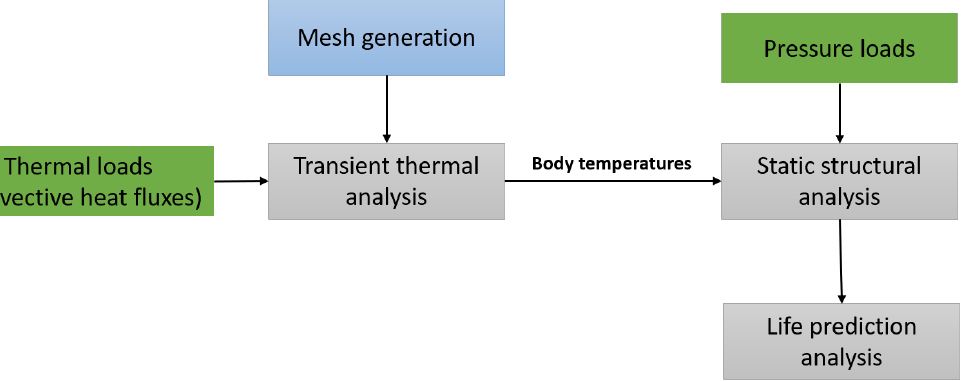
Figure 2. Workflow of the thermal – mechanical FEM analyses.